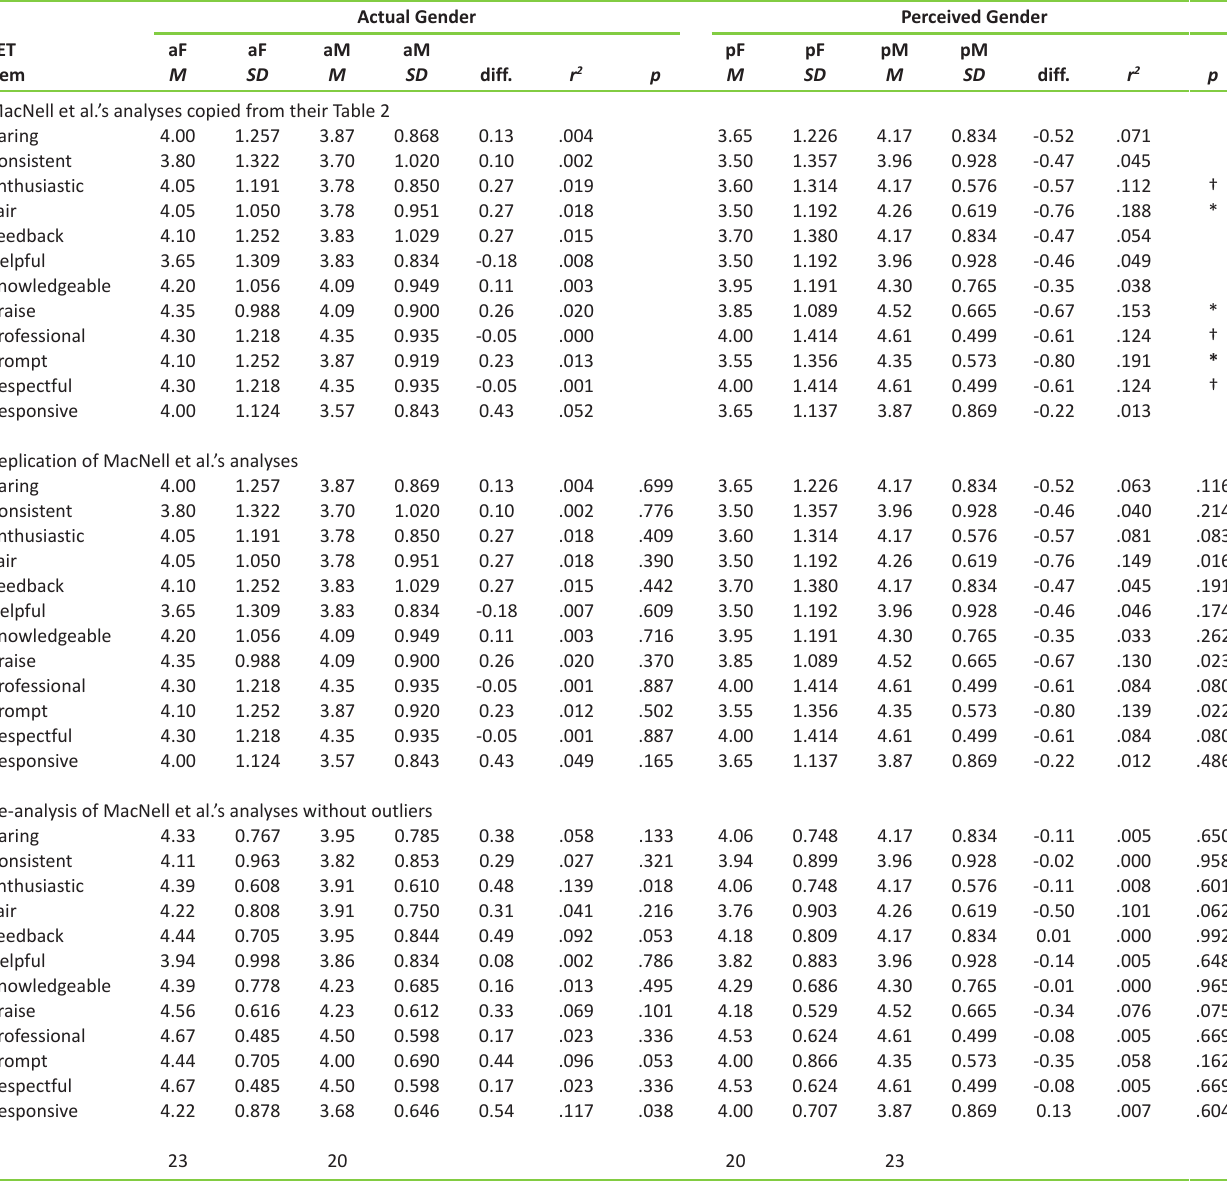
table 2: Mean student ratings of teaching for each of the 12 items used by MacNell et al. [1]. The top third shows the data copied from MacNell et al.’s Table 2; the middle third shows our replication of MacNell et al’.s analyses; and the bottom third shows our replication of MacNell et al.’s analyses with the three outliers